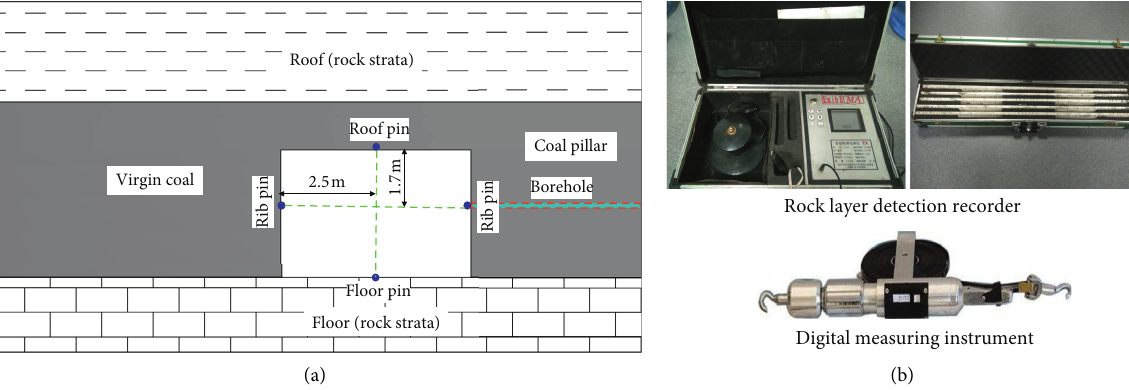
Figure 4: Schematic diagram for roadway measurements. (a) Cross section of the measurement station. (b) Measurement